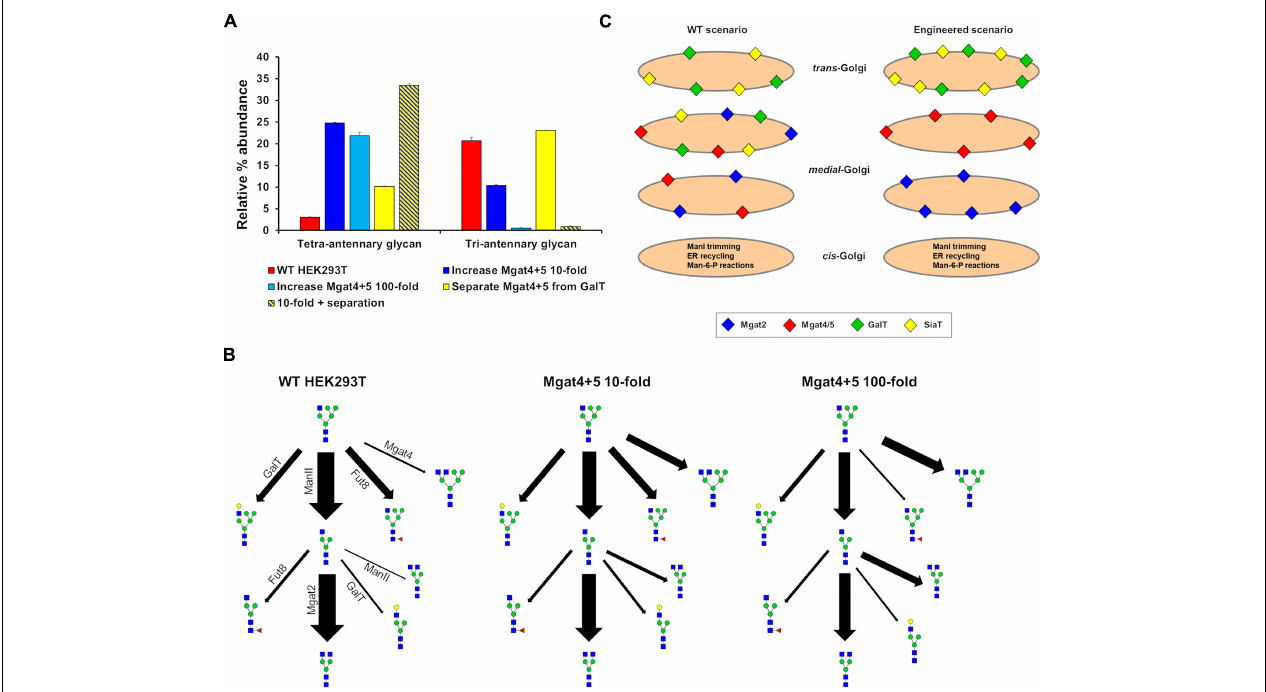
FIGURE 7 | Hypothetical engineering of the Golgi apparatus to increase the abundance of tetra-antennary glycans. (A) The relative abundance of all tetra- and tri-antennary glycans produced in silico using effective enzymatic rates for: WT HEK293T (red), WT with the total effective enzymatic rates of Mgat4/5 increased 10-fold (dark blue), WT with the total effective enzymatic rates of Mgat4/5 increased 100-fold (light blue), WT with the distribution of enzymes in the model Golgi apparatus set to separate Mgat4/5 from GalT (yellow), and WT with the total effective enzymatic rates of Mgat4/5 increased 10-fold and the localization of enzymes in the model Golgi apparatus set to separate Mgat4/5 from GalT (yellow and dark blue striped). (B) Flux diagrams for selected N -glycosylation reactions for WT HEK293T, WT with the total effective enzymatic rates of Mgat4/5 increased 10-fold and WT with the total effective enzymatic rates of Mgat4/5 increased 100-fold. (C) Schematic showing the levels and relative localizations of key enzymes for WT HEK293T cells and the computationally engineered scenario predicted to maximize the production of tetra-antennary